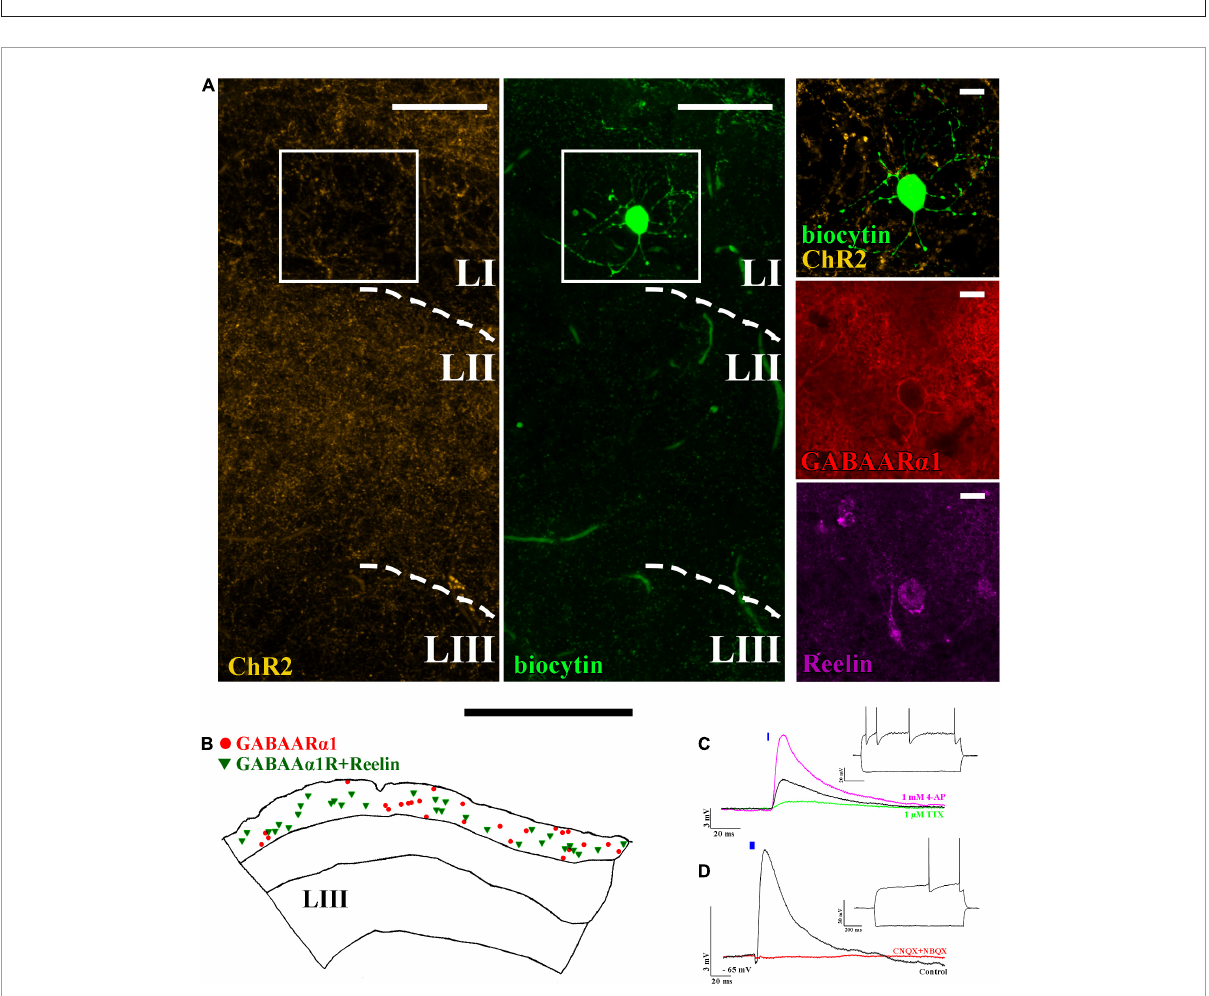
FIGURE2 Layer I neurogliaform cells receive excitatory monosynaptic inputs from layer II pyramidal cells. (A) Confocal image of a biocytin-filled layer I neurogliaform cell surrounded by ChR2-mCherry-positive axons (yellow) (left). The recorded cell shows GABAAR α 1 (middle) and Reelin (right) immunopositivity (scale bars: 15 µ m). (B) Representative reconstruction of somatic locations in a 40 µ m thick section of the mouse medial entorhinal cortex showing layer I GABAAR α 1 (red circle) positive cells together with GABAAR α 1 and Reelin positive cells (green triangle) (scale bar: 500 µ m). (C) The postsynaptic effects seen on neurogliaform cells (black, firing pattern in inset) were reduced by 1 µ M TTX (green). Of note, 1 mM 4-AP not only recovered but also increased the amplitude of the postsynaptic effect, indicating monosynaptic input [RMP: –65 mV, excitatory postsynaptic potential (EPSP) amplitude: before TTX application 3.1 ± 0.6 mV, after TTX application 0.3 ± 0.2 mV and after 4-AP application 9.8 ± 2.9 mV, n = 4]. (D) The voltage response of the neurogliaform cell to a 5 ms photo-stimulation (black, single sweep